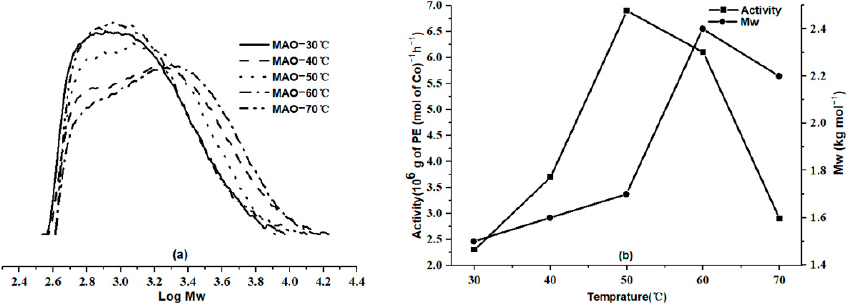
Figure 3. For Co6 /MAO: ( a ) GPC traces of the polyethylene obtained at different run temperature; and ( b ) plots of catalytic activity and M w of the resultant PE as a function of run temperature (entries 1–5, Table 2).